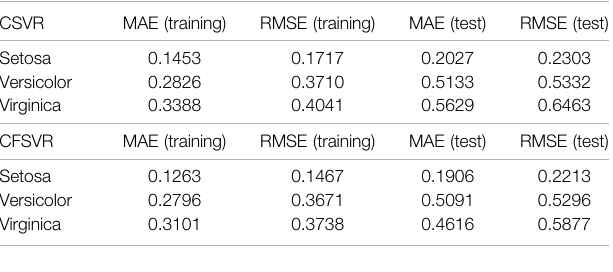
TABLE 3 | Result of iris by CFSVR and